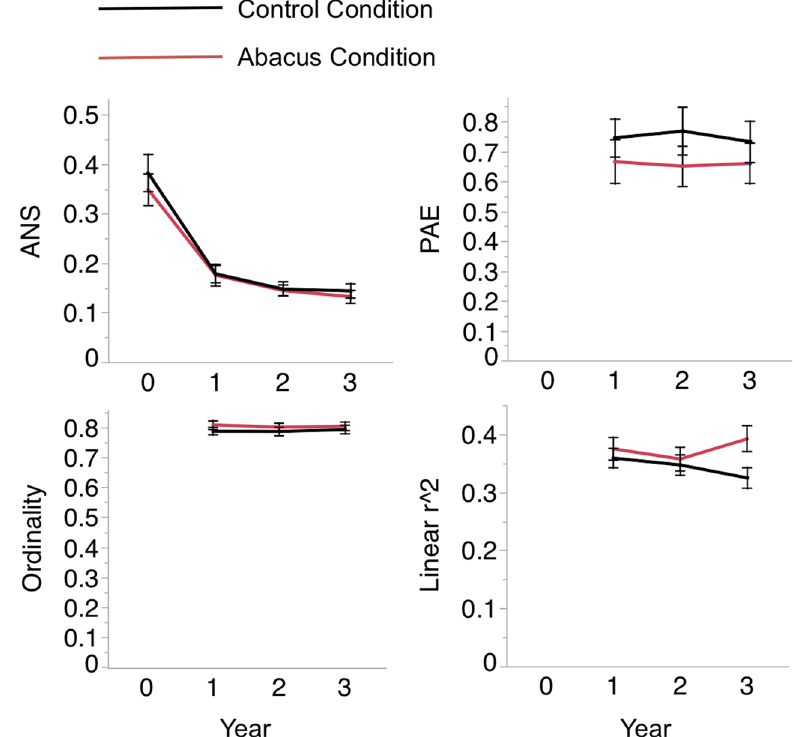
Figure 1. ANS acuity (Years 0, 1, 2, and 3) and estimation performance (Years 1, 2, and 3 – we did not test estimation in Year 0). Red line indicates children who learned abacus; black line indicates children who were in the control group. For Proportion Absolute Error (PAE) and ANS measures, smaller numbers indicate better performance. For our Linear r 2 and Ordinality measures, larger numbers indicate better performance. Error bars are Standard